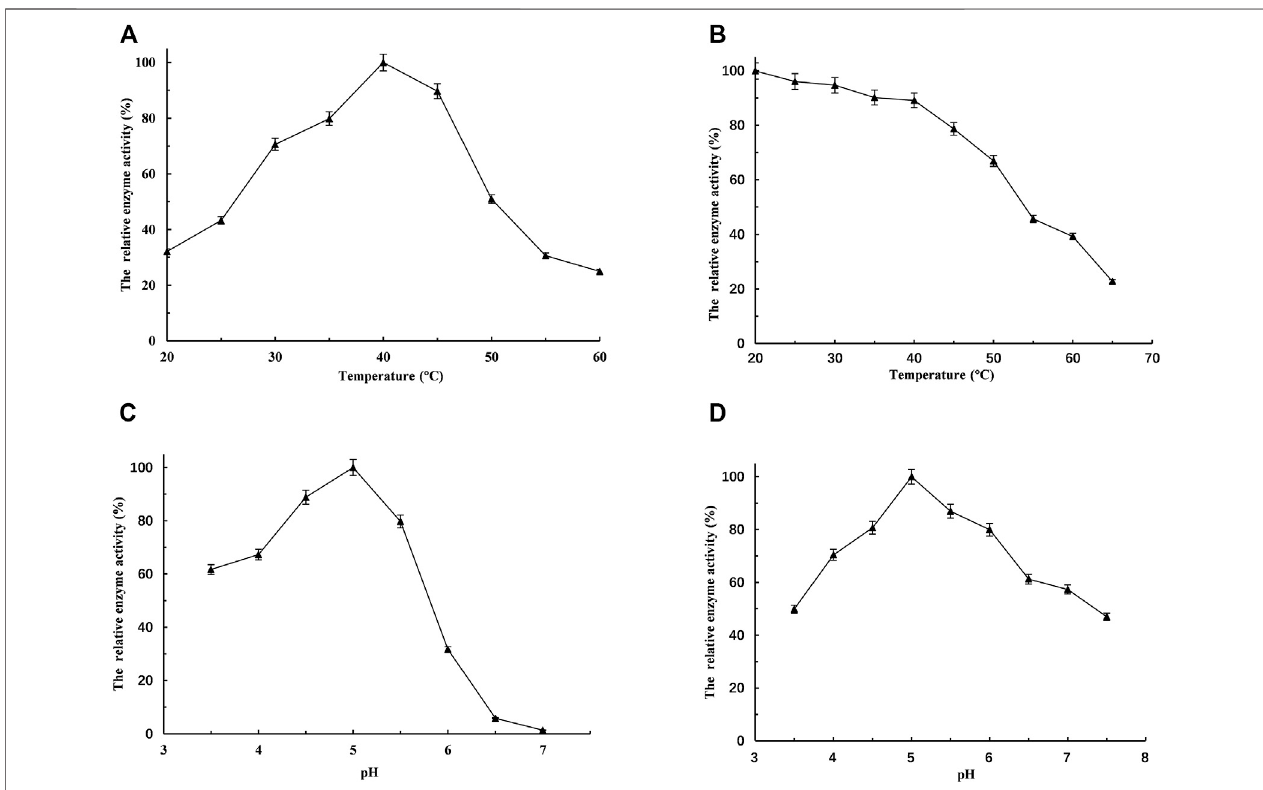
FIGURE. 3 | Optimization of bioconversion conditions of the recombinant L- Lc LDH1 Q88A/I229A (Pp). (A) The temperature optima were measured under the standardassayconditions,buttemperaturesrangedfrom20to60 ° C. (B) Toestimatethetemperaturestability,therecombinantL- Lc LDH1 Q88A/I229A (Pp)wasincubated for 2 h from 20 to 65 ° C, respectively. (C) The pH optima were measured under the above-mentioned assay conditions, except for pH ranging from 3.5 to 7.0. (D) To estimate the pH stability, the recombinant L- Lc LDH1 Q88A/I229A (Pp) was incubated for 1 h in a different pH buffer at 4 ° C, and then the relative activity was determined at the optimal temperature of 40 ° C and optimal pH of 5.0. Means and standard deviations of triplicate experiments are shown.